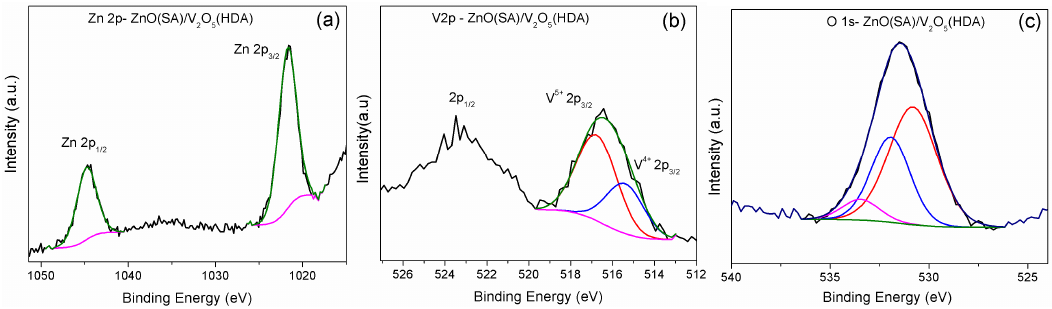
Figure 2. XPS spectra of core level ( a ) Zn2p, ( b ) V2p and ( c ) O1s.